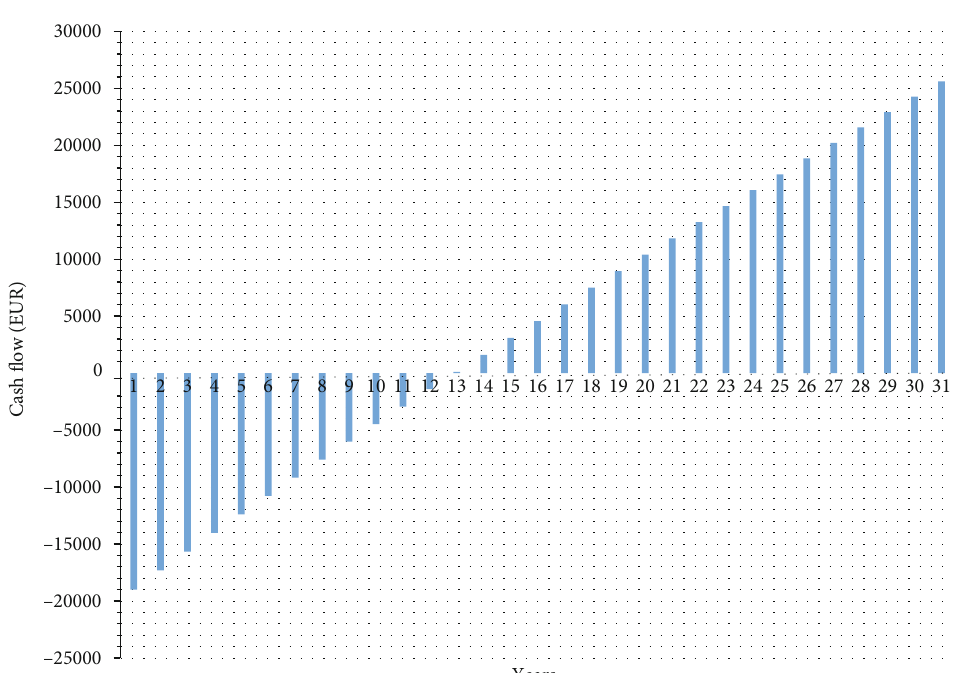
Figure 14: Cash fl ow